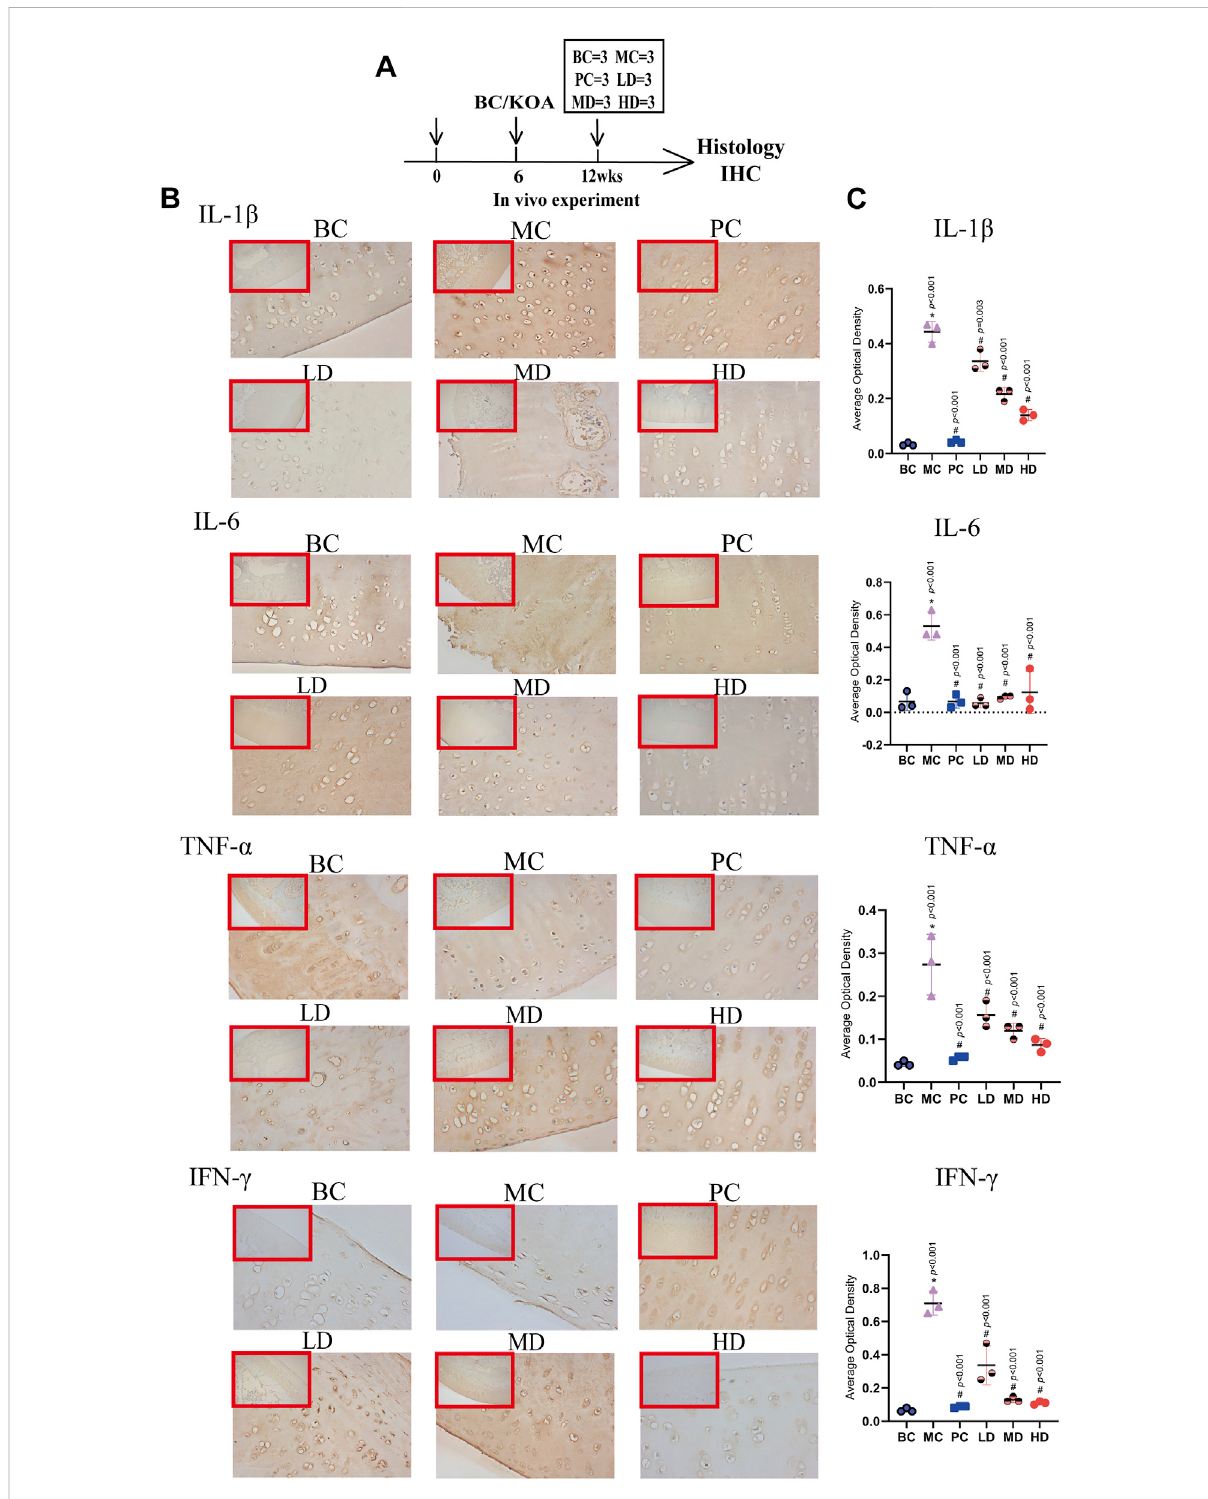
FIGURE 5 Immunohistochemistry of IL-1 β , IL-6, TNF- α , and IFN- γ . (A) Experimental design. The rabbits were killed for immunohistochemical analysis at 12 weeks( n =3/group).(B)Representativeimagesand (C) averageopticaldensity(AOD)analysesofimmunohistochemicalsectionsIL-1 β ,IL-6,TNF- α ,andIFN- γ .Theimagesaremagni fi ed100×(insidetheredrectangularframe)and400×.One-wayanalysisofvariancewasusedforcomparingAOD scores. The data are presented as the mean ± SD. * p < 0.05, vs. BC group; # p < 0.05, vs. MC group. Speci fi c p- values for each pair of comparisons are